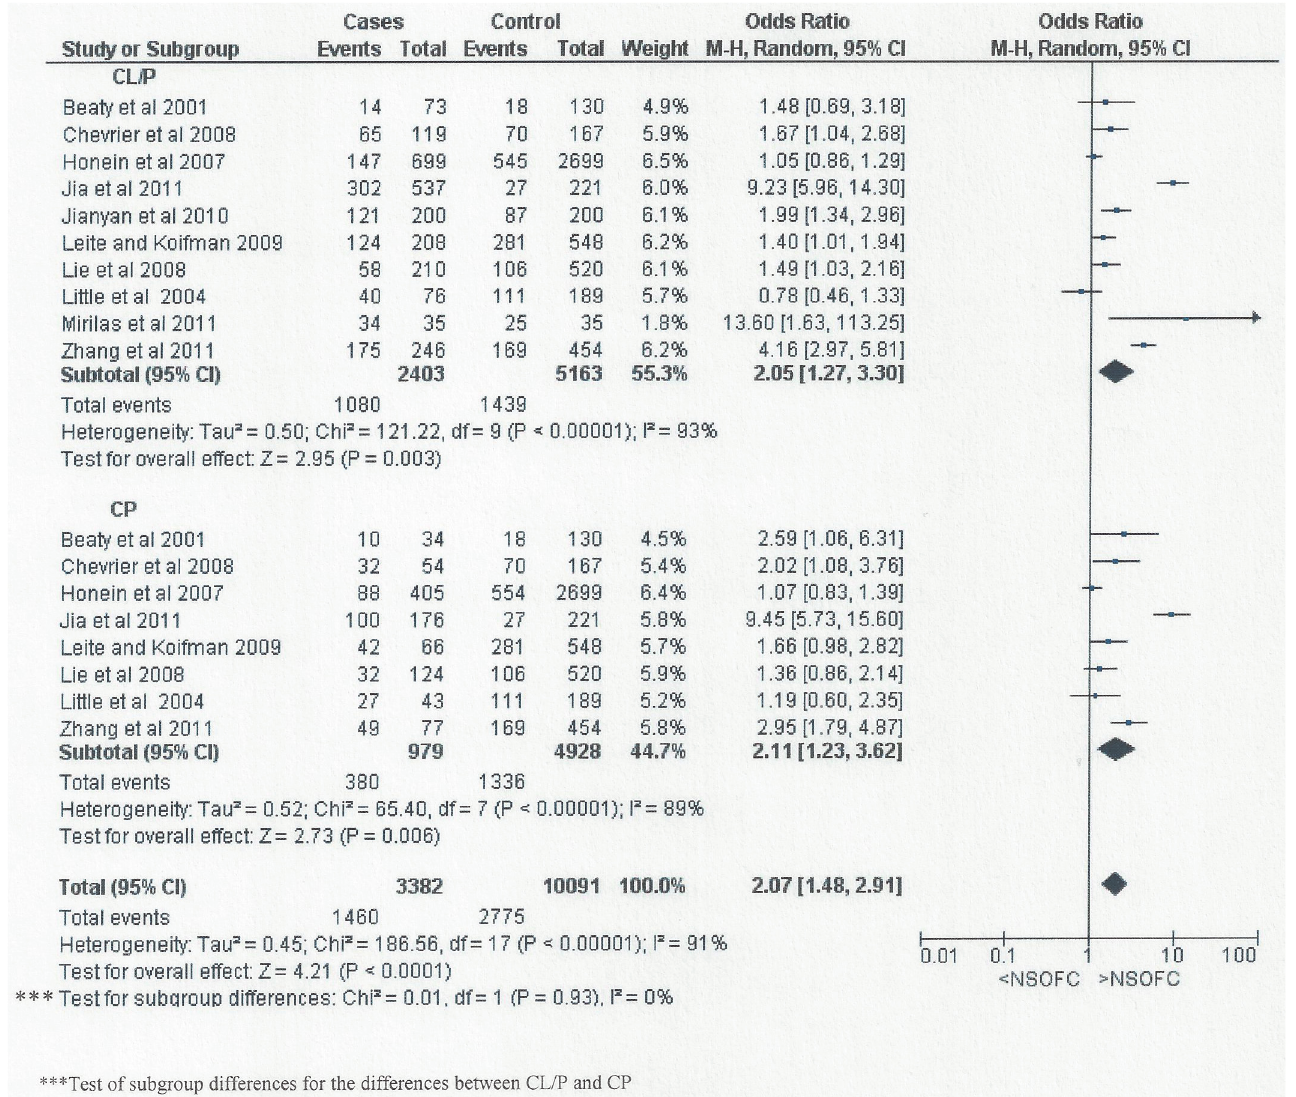
Fig 6. Forest plot for meta-analysis of the association between NSOFC phenotype (CL/P and CP) and maternal passive